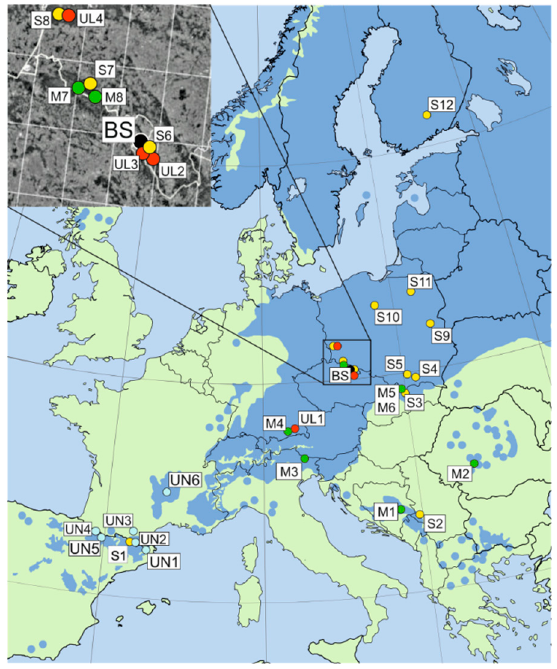
Figure 1. Geographic position of Bł˛edne Skały mixed population (BS) and samples of the reference species— Pinus sylvestris (S), P. mugo s.s . (M), P. uliginosa (UL) and P. uncinata (UN); population acronyms as in Table 1.